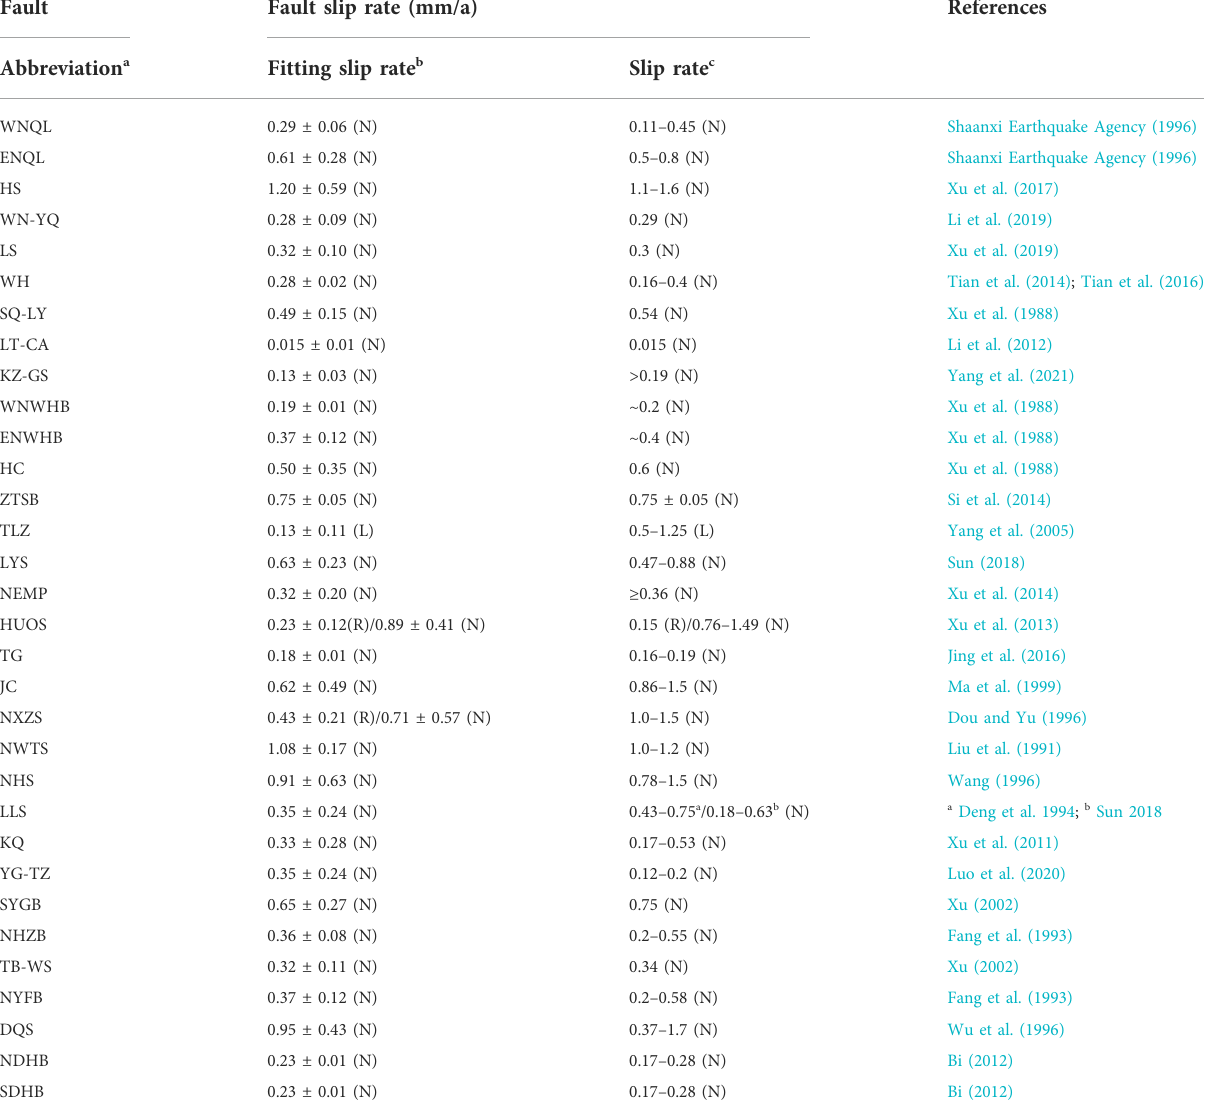
TABLE 2 Comparison of predicted fault slip rates with published studies.